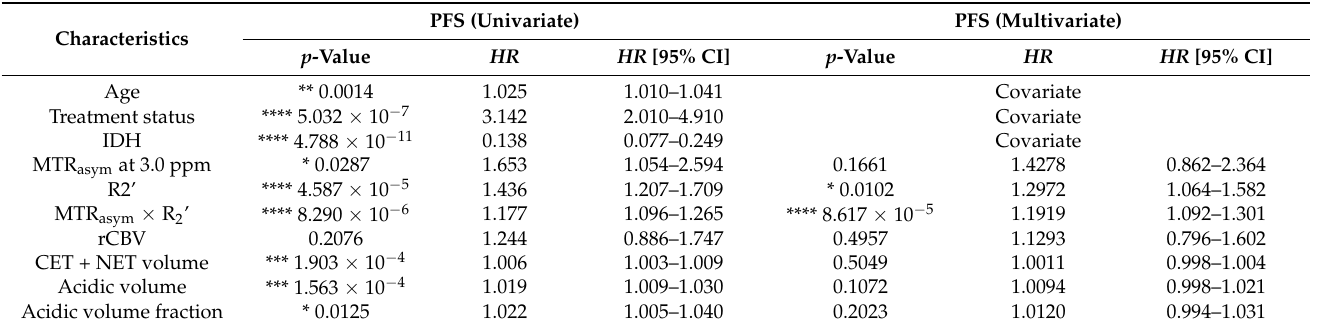
Table 3. Cox proportional-hazards model analysis of glioma residual progression-free survival (all patients).